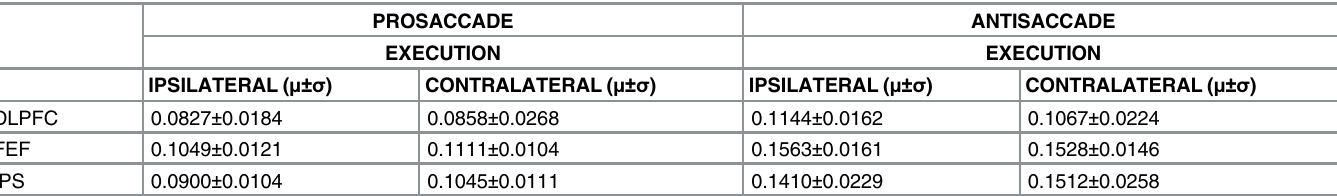
Table 2. Mean and standard error of normalised signal change for each saccade event